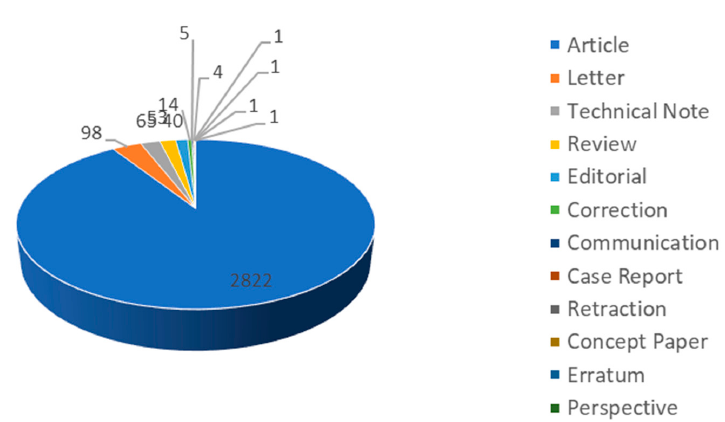
Figure 2. Number of publication types in 2019 for the Remote Sensing Open Access Journal of MDPI.